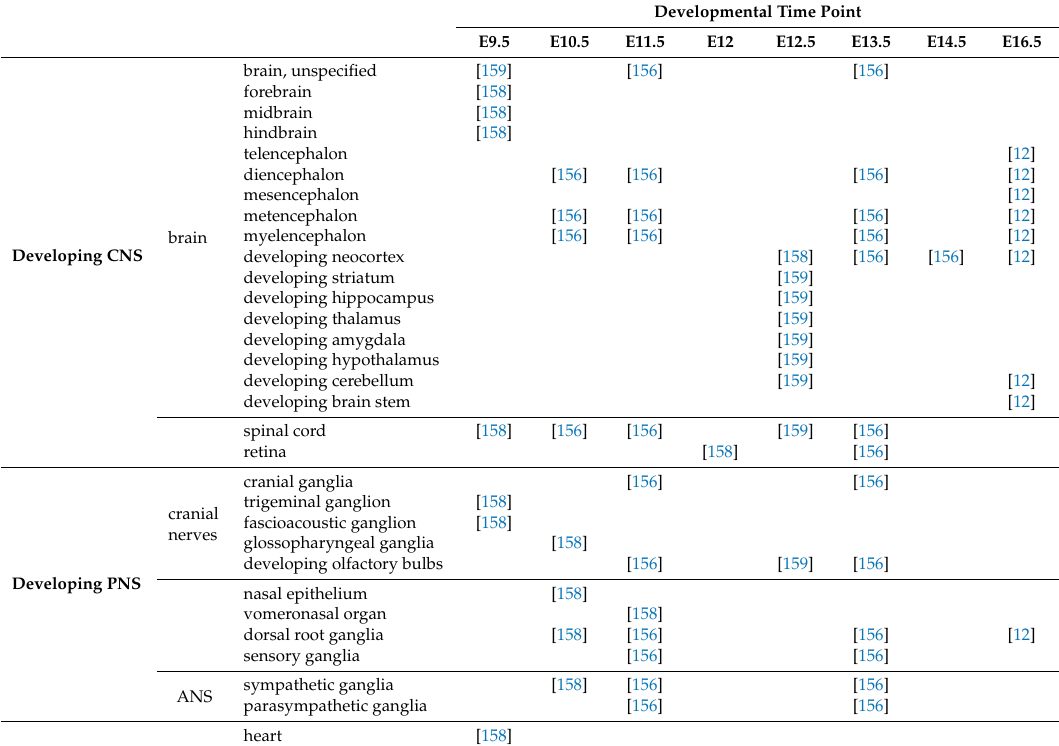
Table 6. Studies of TUBA1A expression during mouse development.